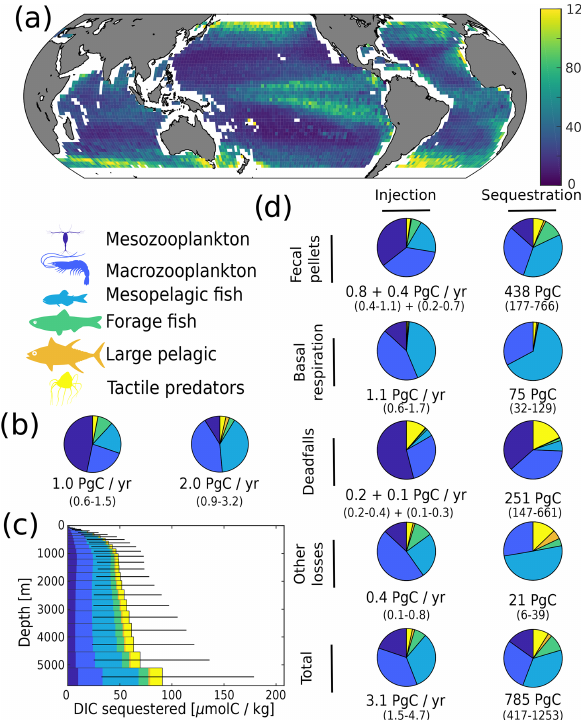
Figure 4. Simulated carbon injection and sequestration by meta- zoans. (a) Simulated injection below the euphotic zone (in mgCm − 2 d − 1 ). (b) Relative contribution of the simulated func- tional groups to injection below the euphotic zone. Left pie chart corresponds to the degradation of organic carbon that was pro- duced in the euphotic zone and subsequently sank below the eu- photic zone; right pie chart corresponds to the degradation of or- ganic carbon that was injected by metazoans directly below the eu- photic zone. (c) Globally averaged concentration of DIC derived from the activity of metazoans according to the depth at which it is sequestered. (d) Relative contribution of the functional groups to injection and sequestration (left and right column respectively) via the different pathways. For fecal pellets and carcass degradation, the first flux value corresponds to the degradation of organic carbon that was produced in the euphotic zone and subsequently sank below the euphotic zone, while the second corresponds to the degradation of organic carbon that was injected by metazoans directly below the euphotic zone. For basal respiration and other losses, only the direct injection below the euphotic zone is reported as there is no sinking flux for these